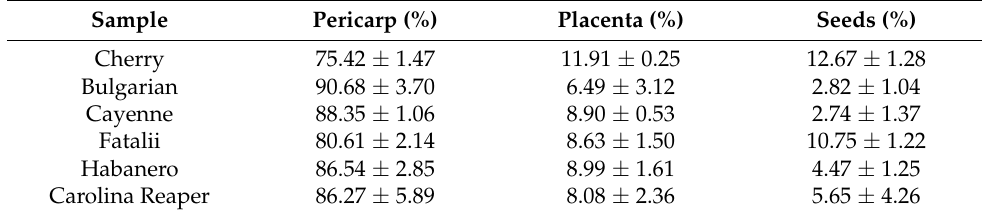
Table 1. Partition of different components of Capsicum fruits (%).